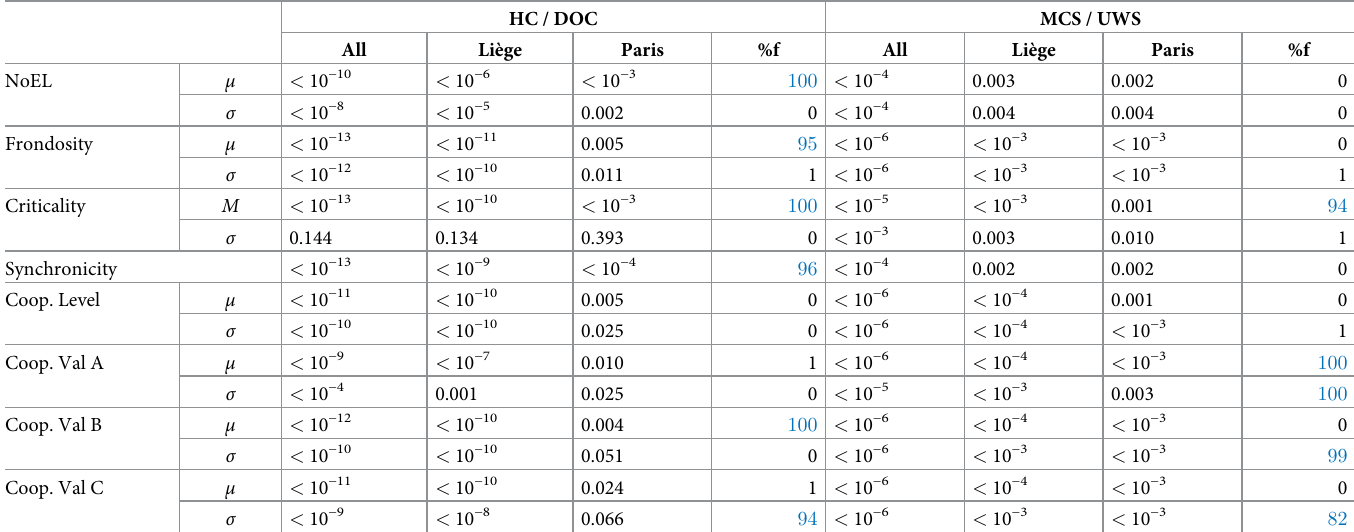
Table 1. Wilcoxon Signed-Rank test for different IS